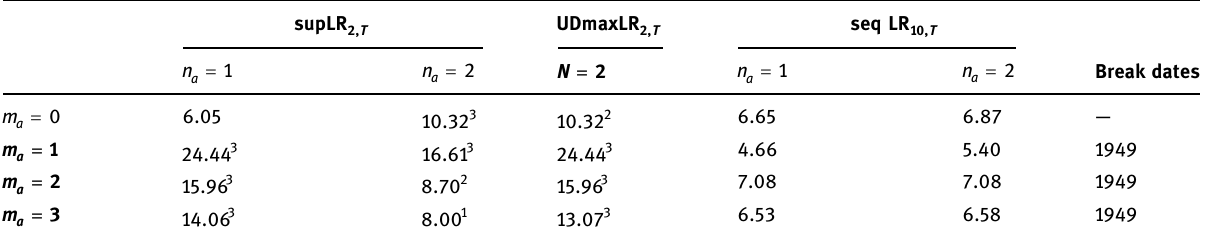
Table 3: Testing for explosive behavior from Phillips et al. ( 2011 ) and Phillips et al. ( 2015a,b ) : Australian real house prices, rhp